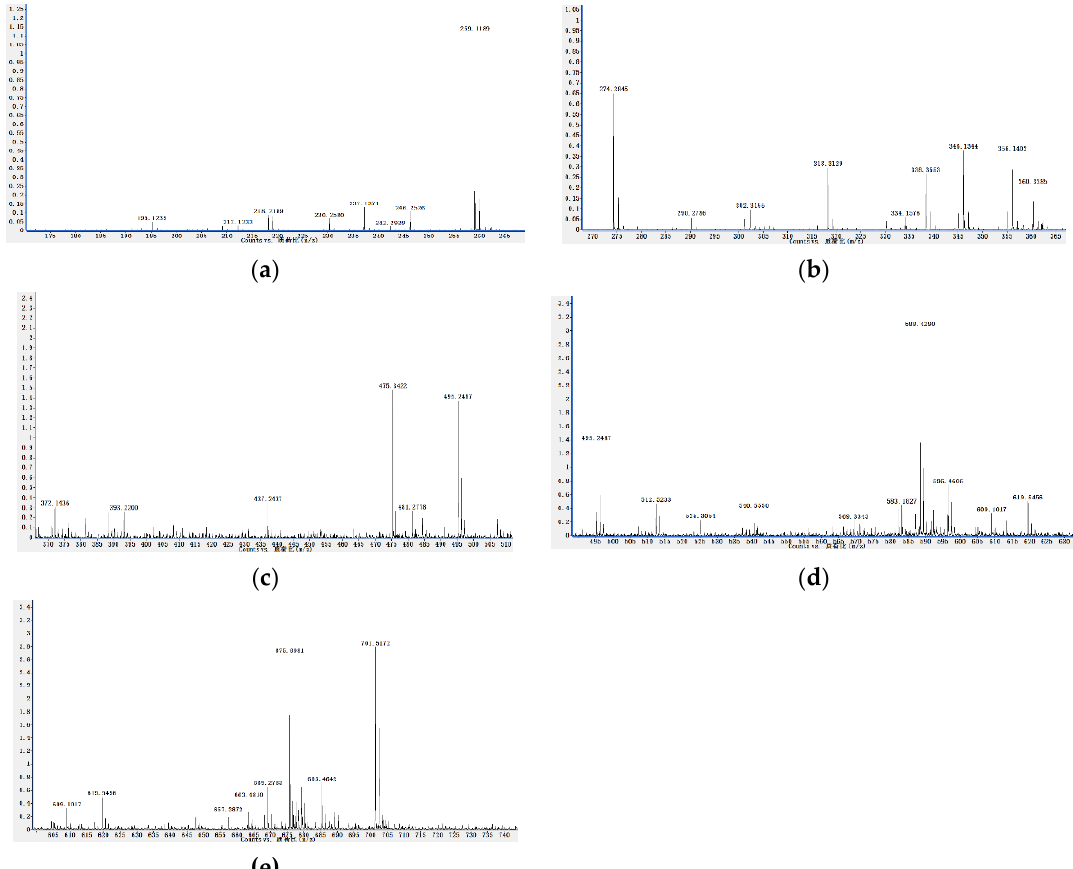
Figure 2. a – e. The full mass spectrum for the purified compound, D3A from Citrullus colocynthis leaves.